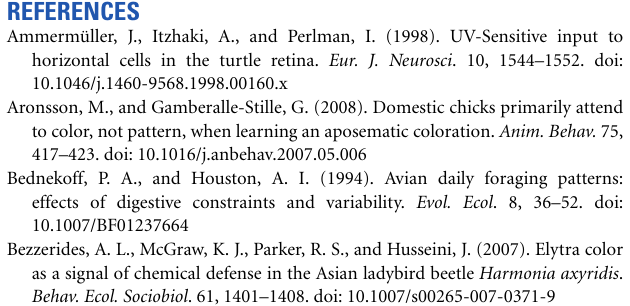
Supplementary Figure 3 | Color contrast of each warning signal against brown backgrounds. The graph shows the contrast of each color signal analyzed under the three opponent channels in the horizontal panels and the different weather conditions in the vertical panels. Similar to the situation presented with the green backgrounds, longwave colors have higher contrasts in both the RG and the BY channels. In the luminance channel, the white and blue signals have higher contrast, as it happens with the green backgrounds. Supplementary Figure 4 | Absolute contrast of the different color signals analyzed over the course of a day under brown background colors. Vertical panels show the absolute contrast of the different signals on the three opponency channels, and horizontal panels compare how this signals change under different weather conditions. In the RG channel, longwave colors have higher contrasts, similar to the results presented for green backgrounds. In the BY channel the tendency remains the same, except for the case of the sunny weather, where black colors have higher contrasts. In the Luminance channel, the white signal has higher contrasts, and these results are comparable to those obtained for the green